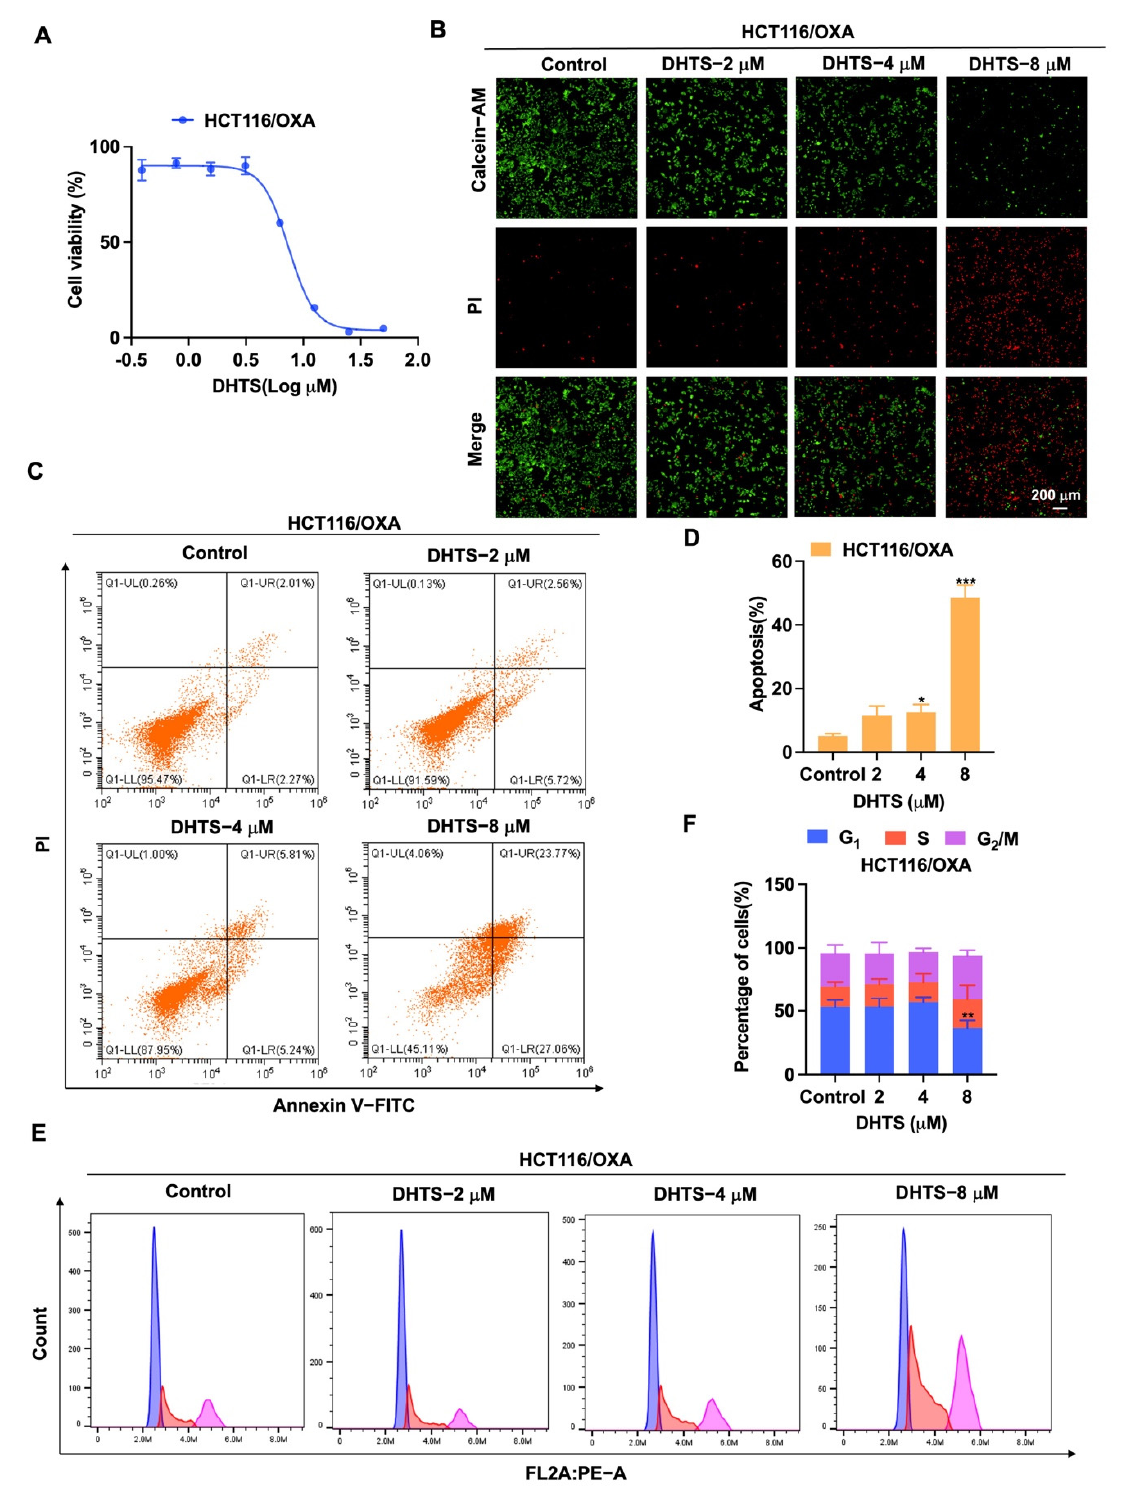
Figure 5. DHTS inhibits proliferation and apoptosis of HCT116/OXA cells. ( A ) Cells proliferation assay of HCT116/OXA cells after DHTS treatment at different concentrations for 48 h by CCK-8 assay; ( B ) cells proliferation assay of HCT116/OXA cells after DHTS treatment at 2, 4, and 8 µ M for 48 h by Calcein-AM/PI staining; ( C – F ) HCT116/OXA cells were treated with DHTS at 2, 4, and 8 µ M for 48 h. Apoptosis and cell cycle distribution of HCT116/OXA cells were detected by flow cytometry (compared to the control group, * p < 0.05, ** p < 0.01, *** p <